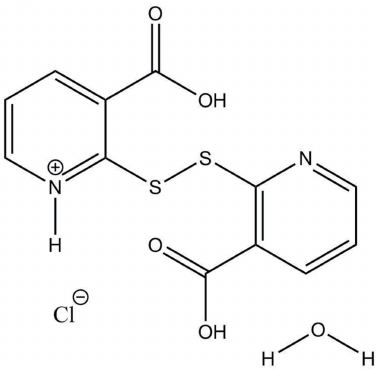
Figure 2 The packing of H(2-mnaH) 2 Cl (cid:2) H 2 O, as viewed down the a axis. Note the zigzag shape of the layers, and the offset configuration of the nicotinic acid rings. Color code: yellow, sulfur; brown, carbon; pale blue, nitrogen; green, chlorine; pale pink, hydrogen.